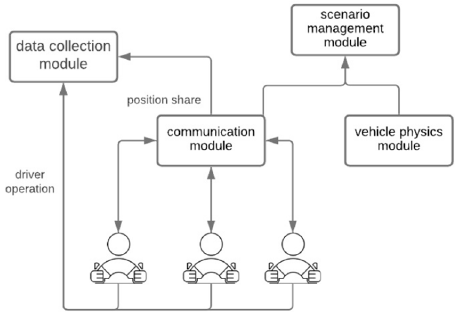
Figure 2 Multi-driver driving simulator system